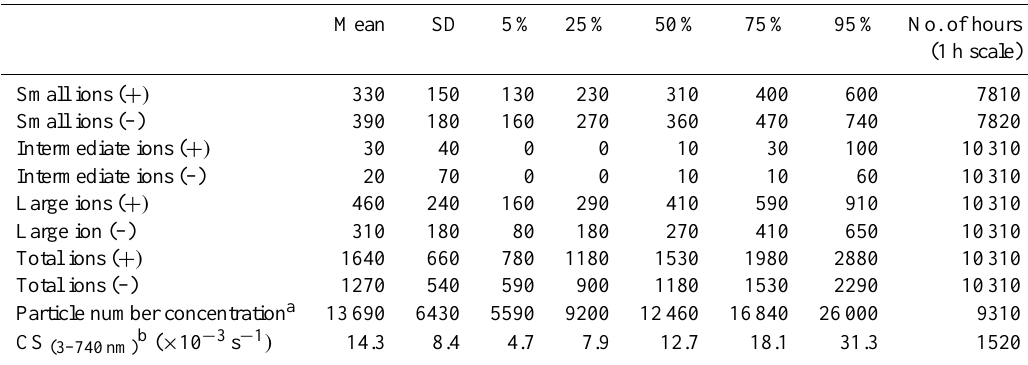
Figure 3. Seasonal variations of particle number (d) and positive/negative ions (a–c) . The bars represent median concentrations, the whiskers represent 25th and 75th percentiles, and n ( ± ) represents the number of hours included in each season (winter/spring/summer/autumn). Table 1. Statistical summary of particle number concentration (6–740nm), small (0.8–2nm), intermediate (2–7nm), and large ion (7–20nm) number concentrations in Paris for the entire campaign. Total ions represent ions in the size range of 0.8–42nm in size. Concentrations were presented as particlescm − 3 and were based on 1h